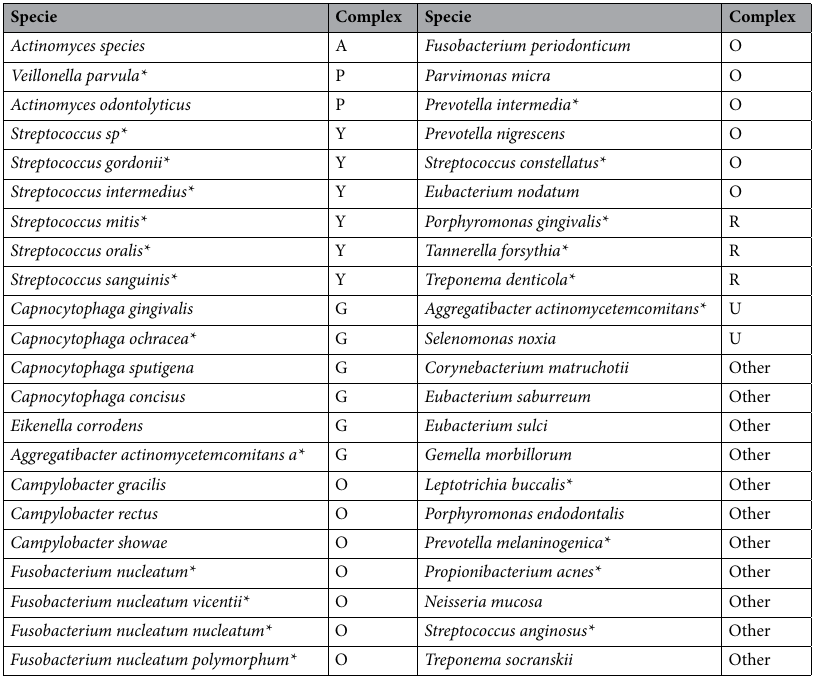
Table 4. Subgingival plaque bacterial complexes and their species as described by Socransky and Haffajee. The species identified in the present study are marked with an asterisk. The proportion of counts of Fusobacterium nucleatum was significantly less frequent in the CAD patients compared to the healthy individuals. Porphyromonas gingivalis was significantly more frequent in the CAD group before adjustment for multiple testing. Aggregatibacter actinomycetemcomitans, Fusobacterium nucleatum subspecies were aggregated in one group according to their specie. Complex: A, Actinomyces; P, Purple; Y, Yellow; G, Green; O, Orange; R, Red; U,